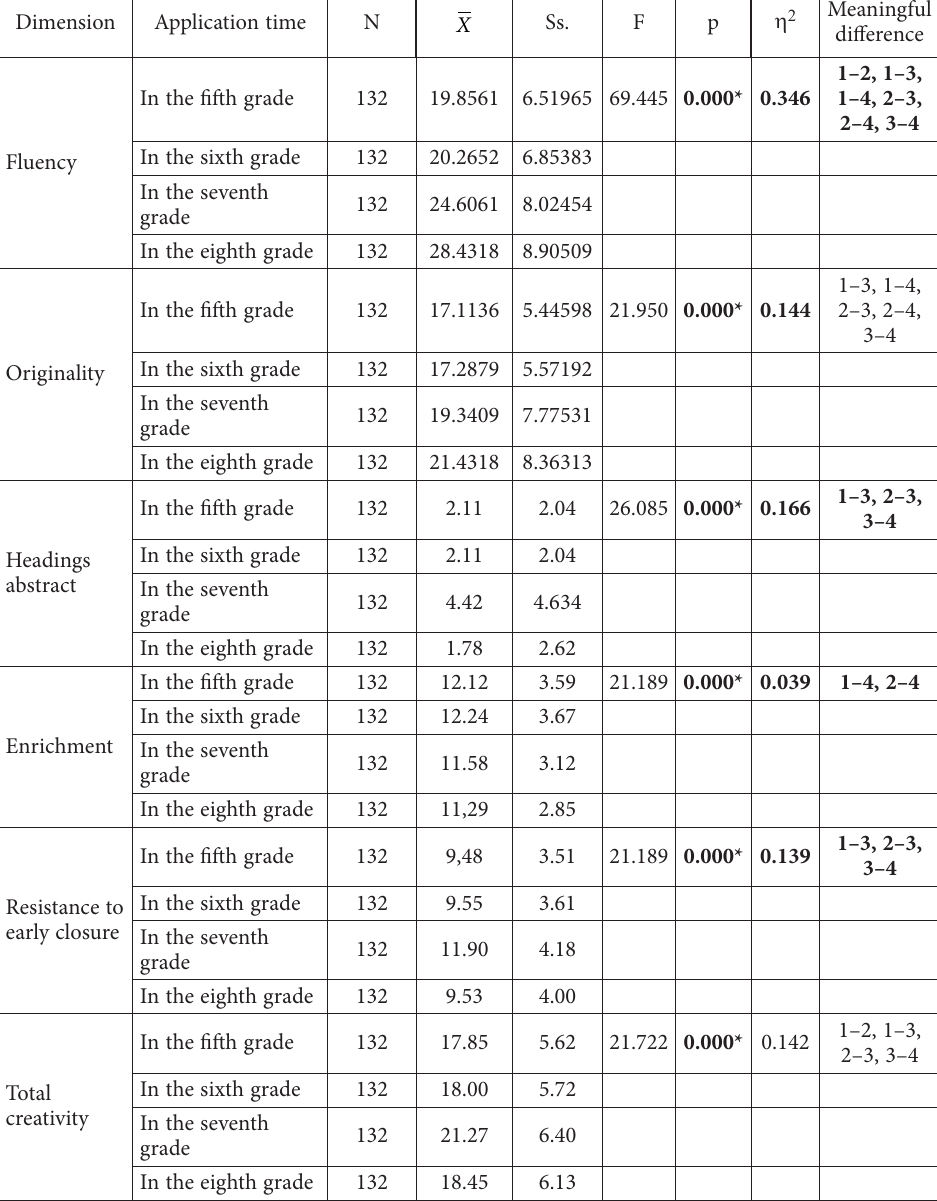
Table 4. Results of analysis of variance test according to the creativity scores of the participating chil- dren in the fifth, sixth, seventh and eighth grades (source: created by author)